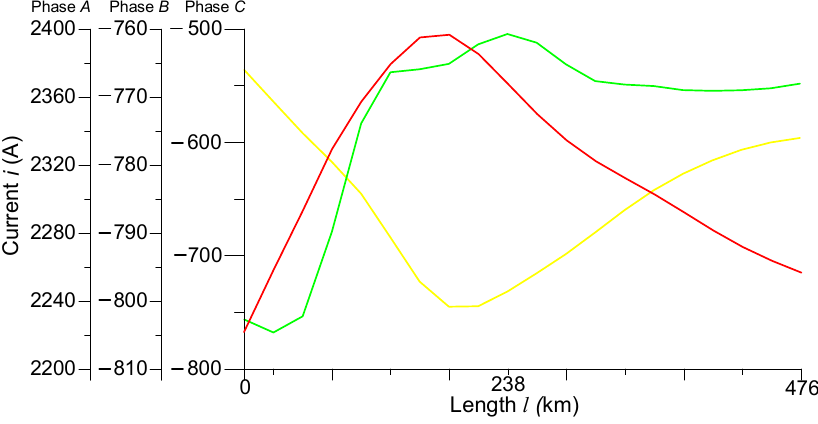
Figure 9. Spatial distributions of phase currents in the line at time t = 0.004 s.